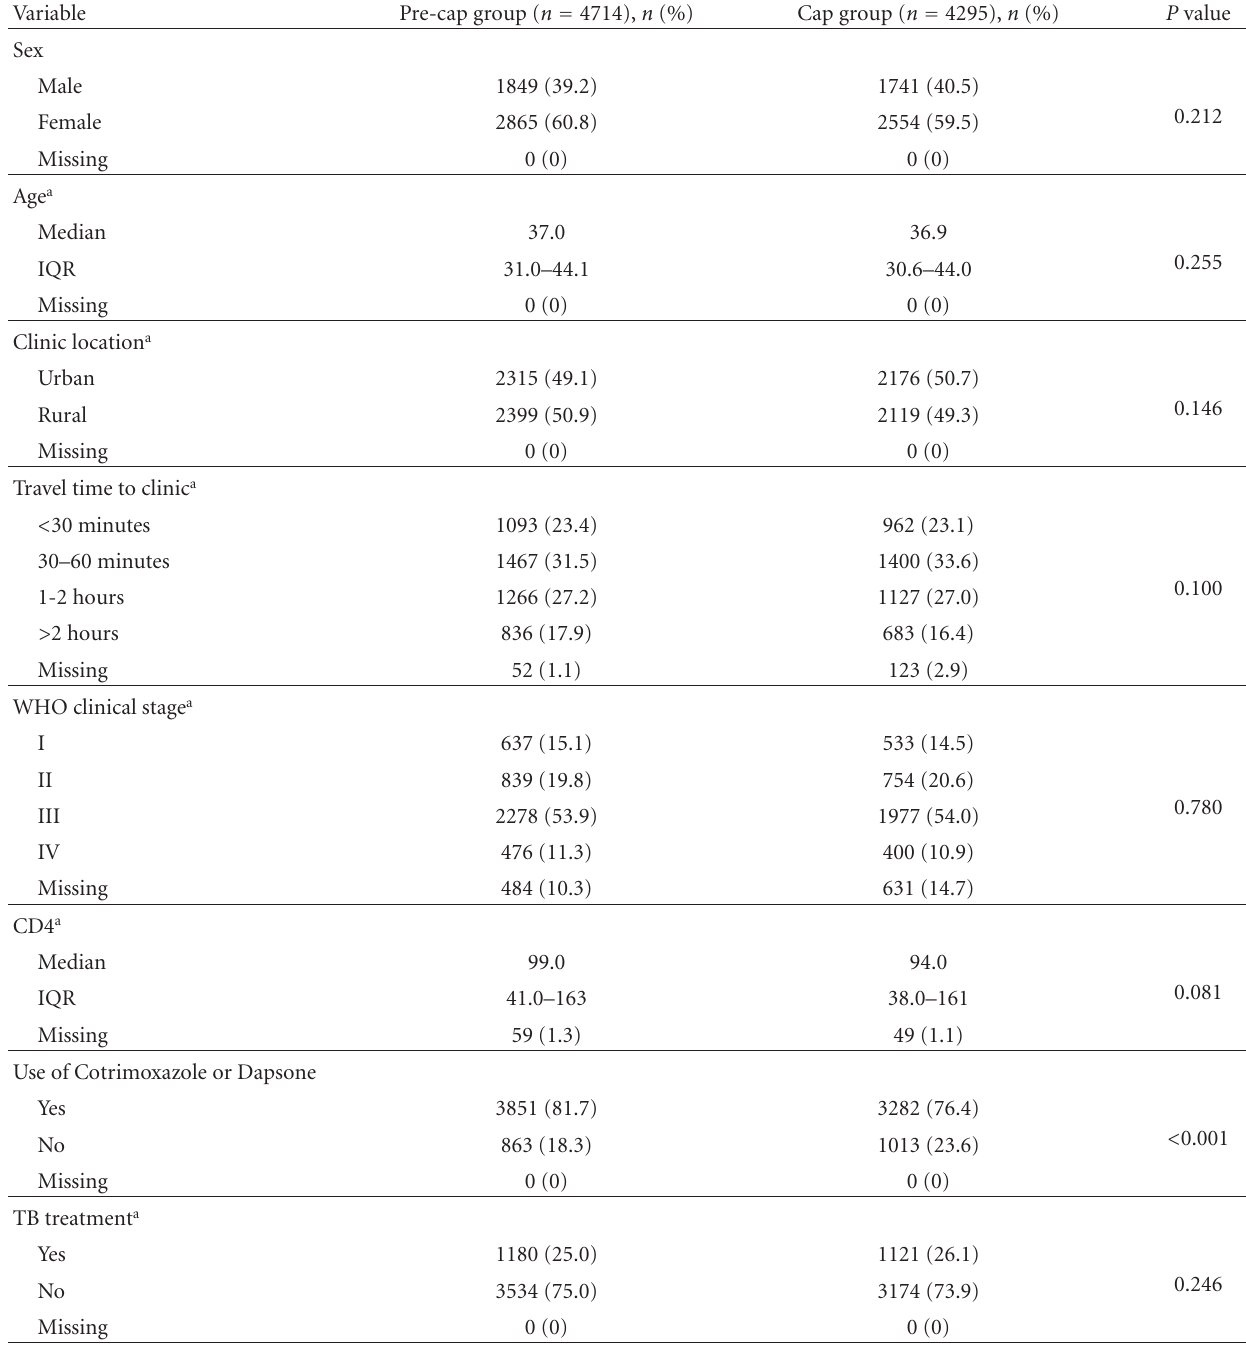
Table 1: Enrollment sociodemographics and clinic characteristics of the comparison